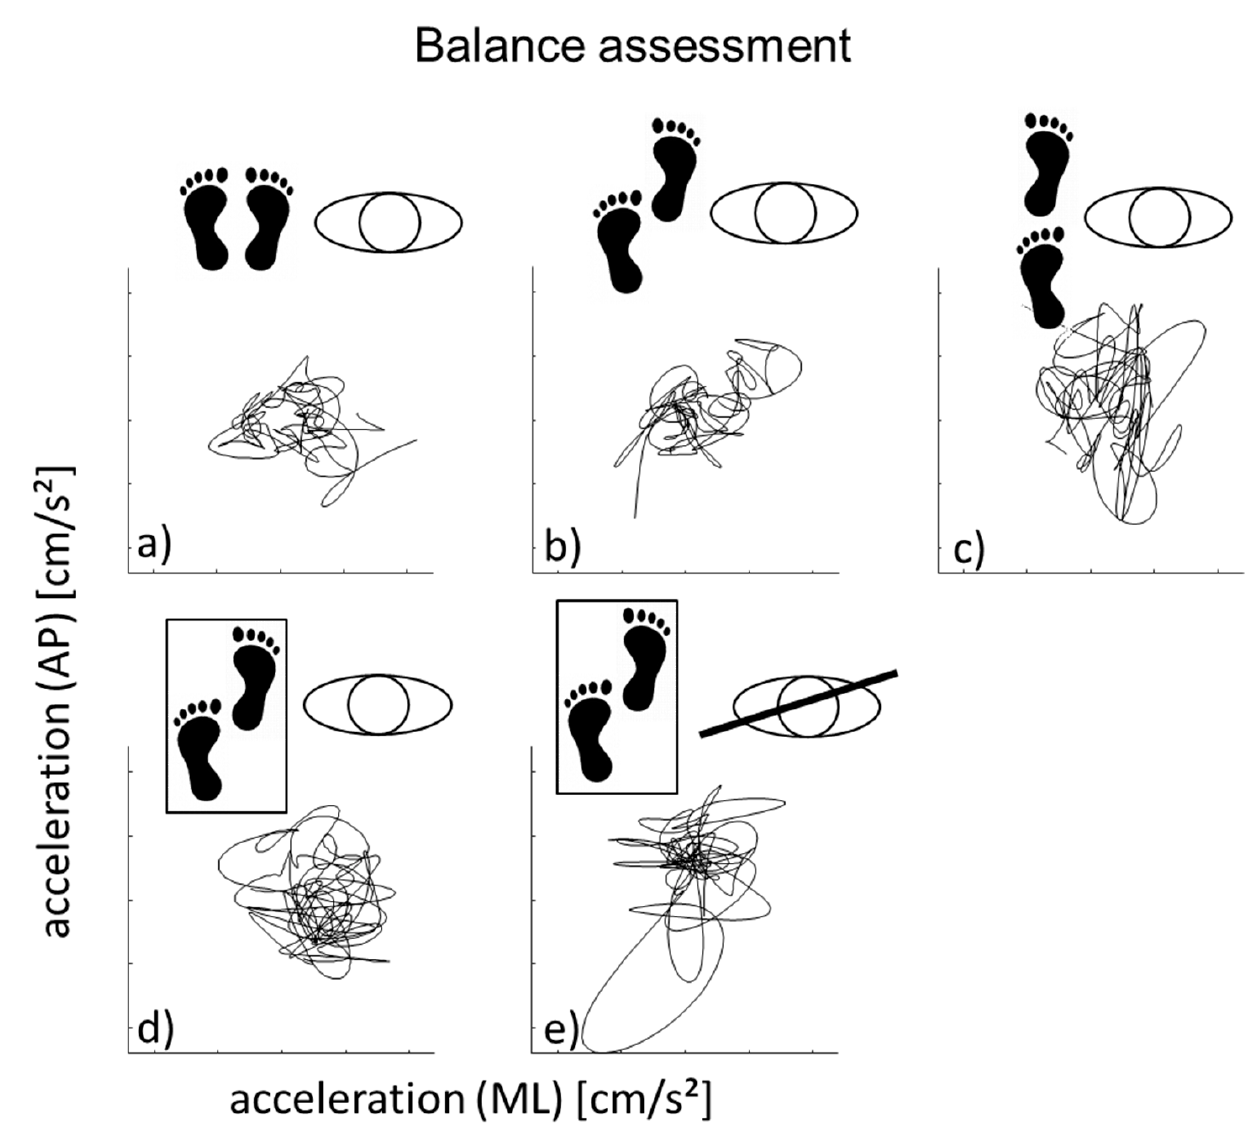
Figure 1. The balance assessment contains three different foot positions on a flat hard surface (side-by-side ( a ), semi-tandem ( b ), tandem ( c )) and a condition on a balance mat (black outline) in a semi-tandem stance with eyes open ( d ) and closed ( e ). The acceleration traces in the horizontal plane (medio-lateral (M/L) and anterior-posterior (A/P) directions) for one representative participant are shown under each balance condition.